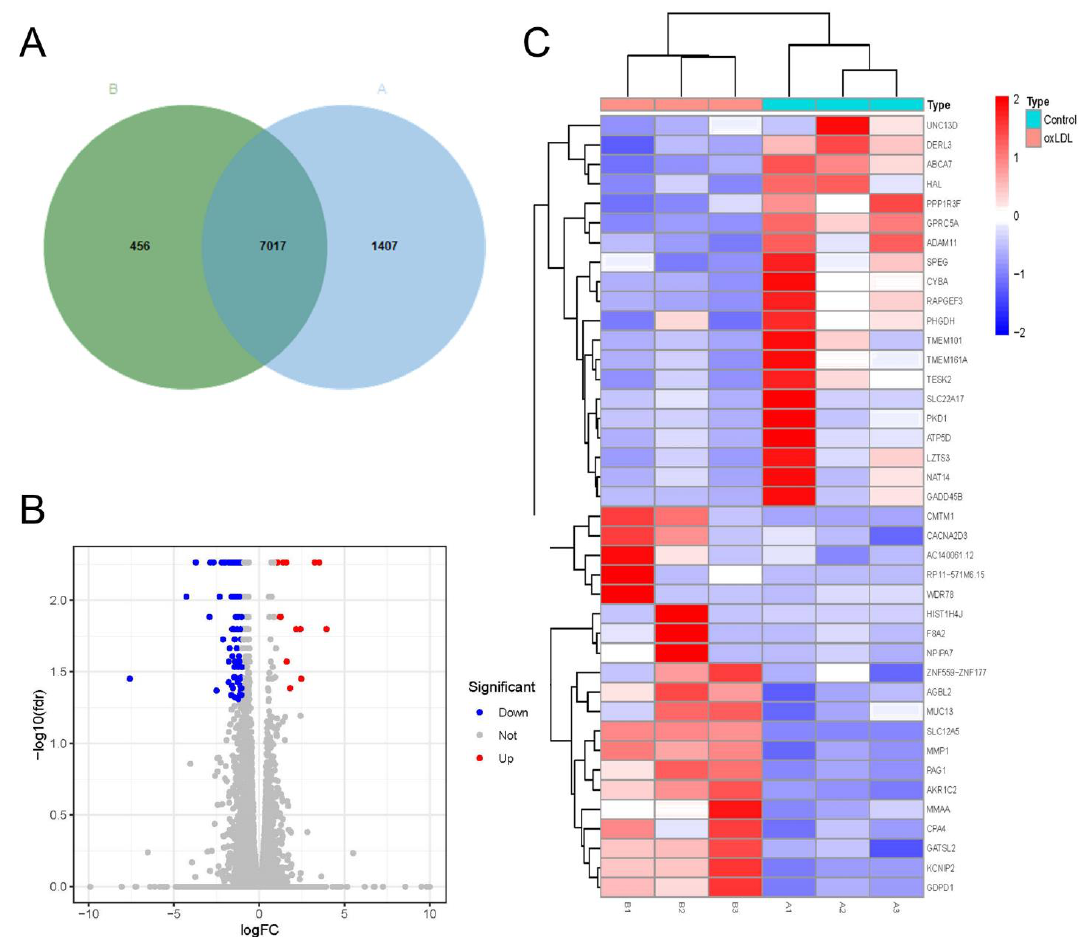
Figure 4. Characteristics of mRNA expression profiles in proliferation and migration models of HCASMCs: ( A ) The number of coding genes in the proliferation and migration models of HCASMCs and the control group. ( B ) The volcano plots of the differentially expressed genes. ( C ) The heatmap of the top 20 highly expressed genes and top 20 lowly expressed genes.